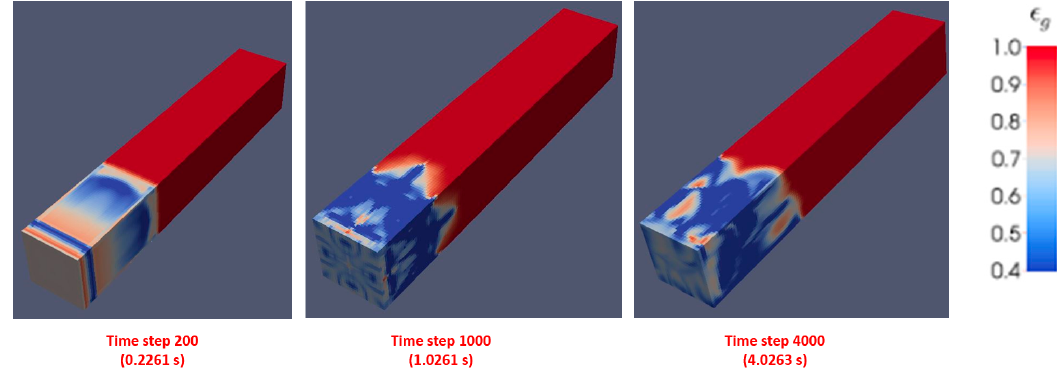
Figure 22. Three different time-steps with different flow characteristics. Figure 22. Three di ff erent time-steps with di ff erent flow